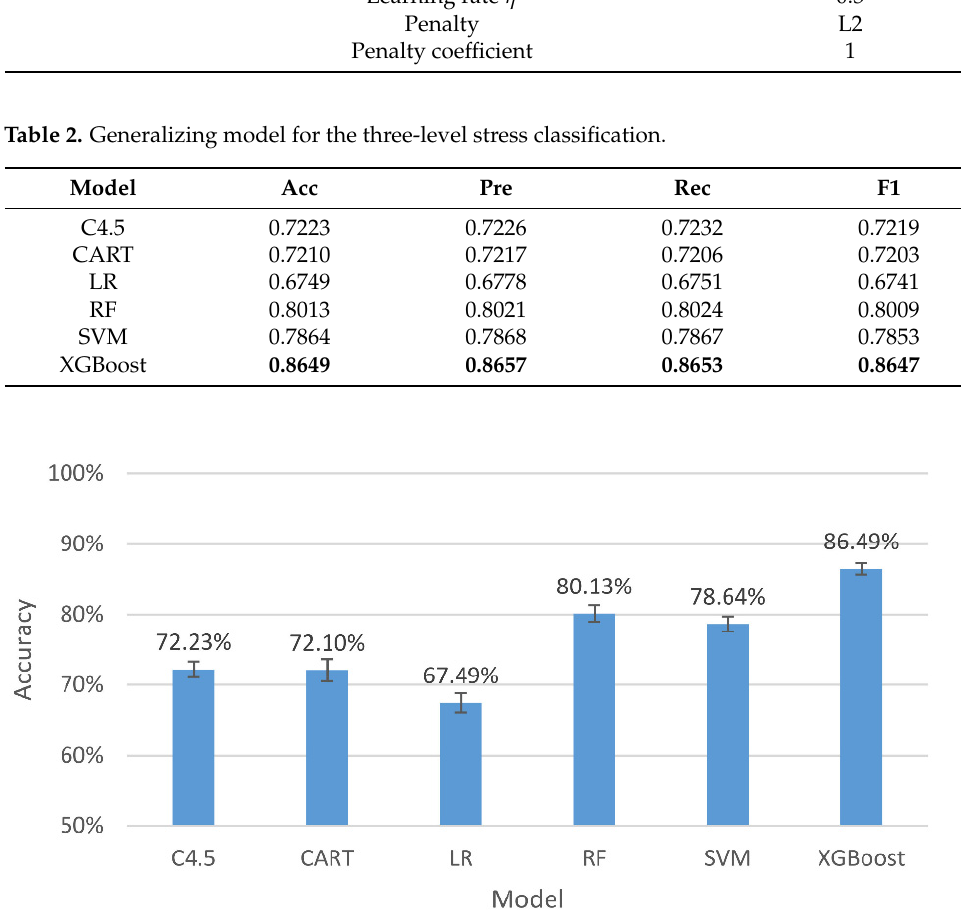
Figure 4. The accuracy and 95% confidence intervals of the generalizing models for the three-level classification.